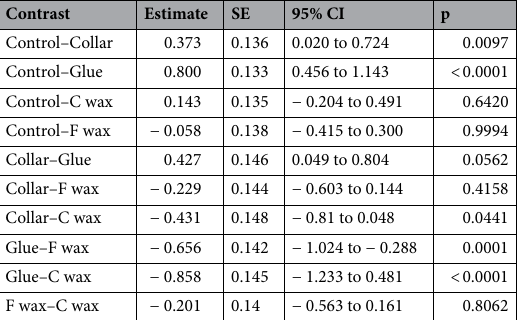
Contrast Estimate SE 95% CI